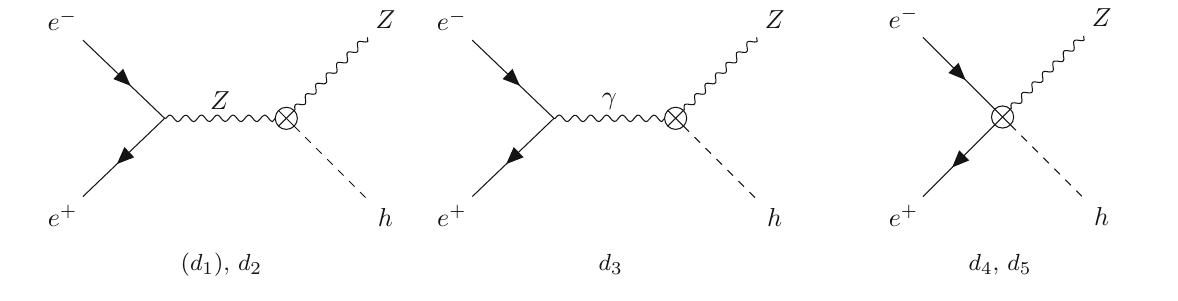
Fig. 2 Diagrams with effective vertices contributing to Eq. (27)